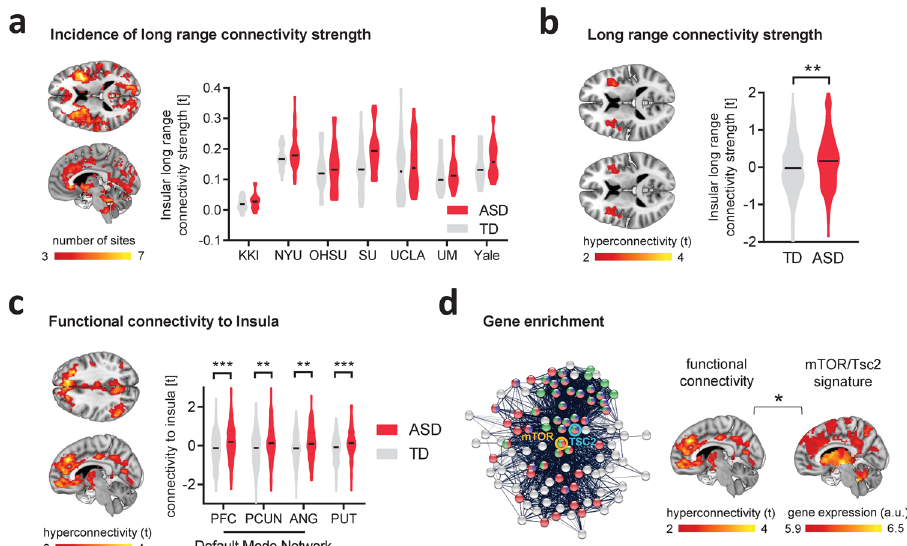
Fig. 4 Fronto-insular-striatal hyperconnectivity in ASD children is associated with a Tsc2/mTOR gene expression signature. a Voxelwise long-range connectivity mapping showed prominent rsfMRI hyperconnectivity in the anterior insular cortex of children with ASD vs. TDs. Red – yellow represents the occurrence rate i.e., the number of datasets presenting rsfMRI overconnectivity (Cohen ’ s d > 0.2, left). Region-wise quanti fi cation con fi rmed that long- range rsfMRI connectivity of the anterior insular cortex is consistently increased in all seven sites of the ABIDE-I collection (Cohen ’ s d range, min = 0.06 [UM], max = 0.75 [SU], right). b Long-range rsfMRI connectivity mapping of the aggregated ABIDE datasets con fi rmed the presence of signi fi cant bilateral foci of functional hyperconnectivity in the insular cortex of ASD vs TD children (unpaired t test, two-sided, t = 3.04, P = 0.003). Error bars represent SEM. c Seed-based probing shows functional over-synchronization between anterior insula, and basal ganglia, and prefrontal cortices in children with ASD vs. TDs. Regional quanti fi cation con fi rmed increased rsfMRI connectivity between insula and PFC (unpaired t test, two-sided, t = 3.94, P < 0.001), p recuneus (unpaired t test, two-sided, t = 3.26, P = 0.002), angular gyrus (unpaired t test, two-sided, t = 3.13, P = 0.002) and putamen (unpaired t test, two-sided, t = 4.33, P < 0.001) in ASD vs. TDs. PFC prefrontal cortex, PCUN precuneus, ANG angular gyrus, PUT putamen. Error bars represent SEM. d Network- based visualization of Tsc2-mTOR interactome used for gene enrichment. The pictured interactome is limited to 100 genes for visualization purposes. Tsc2 seed gene is highlighted in light blue and mTOR seed gene in orange. Nodes that belongs to “ Reactome mTOR signaling ” are in green, those that are part of the “ KEGG mTOR signaling pathway ” are in red, and those that belong to “ GO:0032006 regulation of TOR signaling ” are in blue (left). The ASD functional hyperconnected phenotype is enriched for genes that are part of the Tsc2-mTOR interactome and reported to be dysregulated in ASD. * P < 0.05, ** P < 0.01. *** P < 0.001. Source data, including gene lists, are provided as a Source Data fi